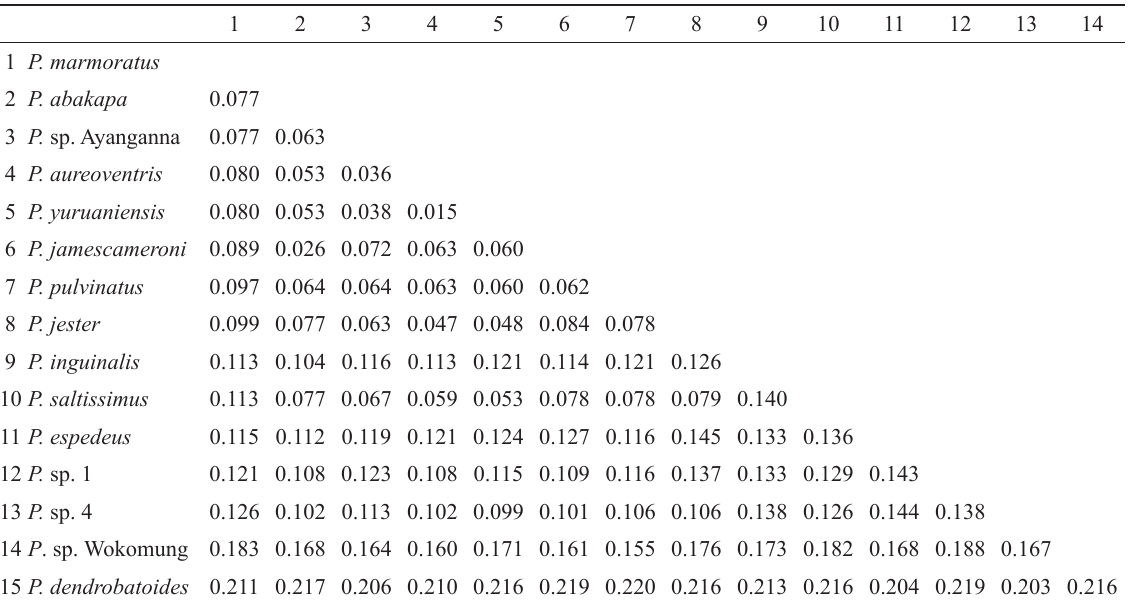
Table 3. Mean genetic distances (p-distances) among major lineages of the Pristimantis “ unistrigatus group” in the Guiana Shield using pairwise